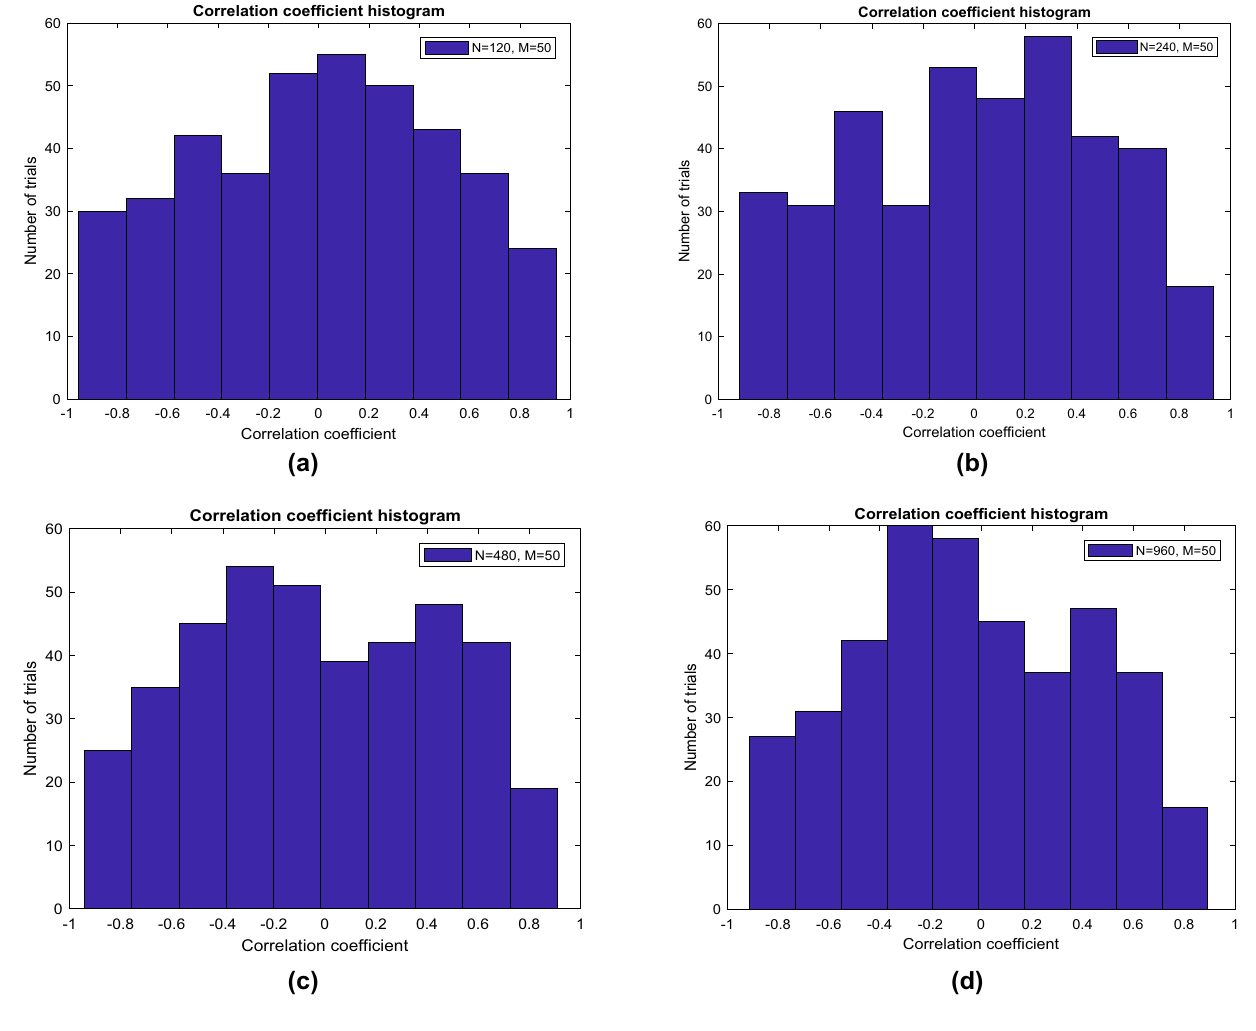
Fig. 10 Distribution of the correlation coefficient between the actual data and the estimated data for a N = 120, M = 50, b N = 240, M = 50, c N = 480, M = 50, d N = 960, M = 50. None of the distribu-